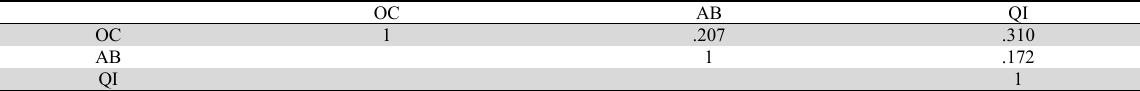
Correlations among the explanatory variables